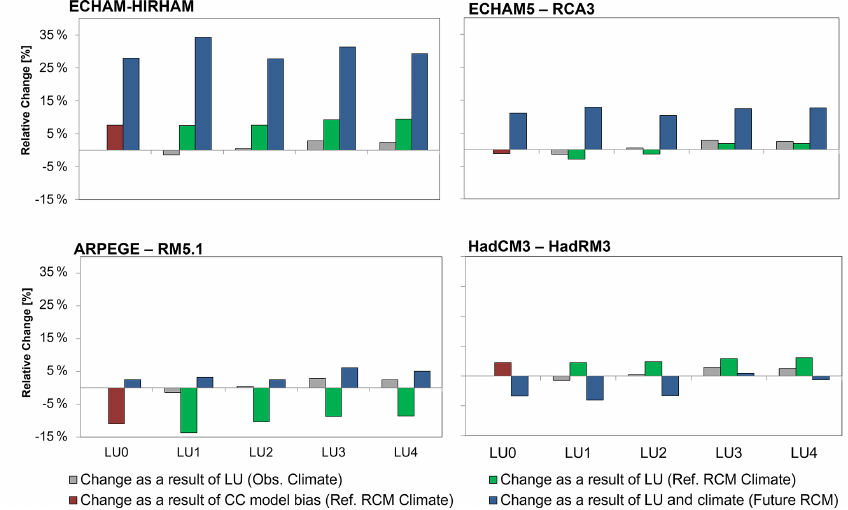
Figure 6. Bars denote the change in nitrate flux at the catchment outlet that arises from using either a fixed nitrate reduction potential map (baseline) or using a reduction map based on the individual scenarios. The scenarios encompass cases with different land use (grey), climate model data for the present (red bar) with land use changes (green bars), or future climate data and land use changes (blue bars).